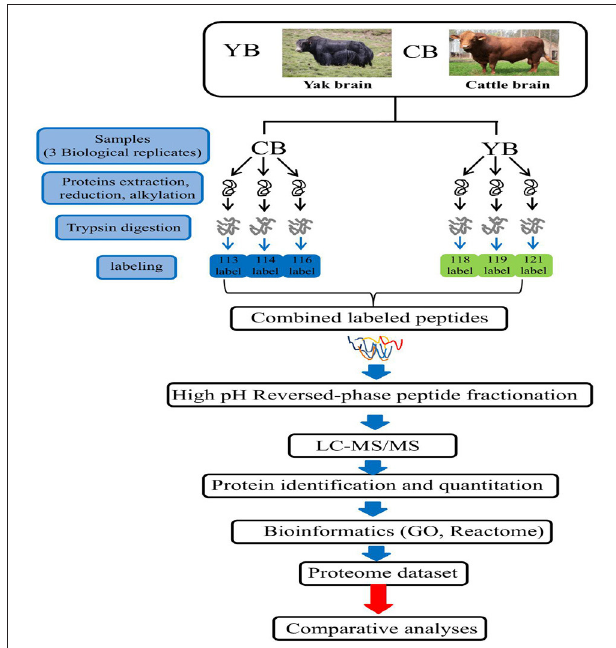
FIGURE 1 | The iTRAQ LC-MS/MS strategy for quantitative proteomic analysis of brain mitochondrial proteins in yak and cattle.